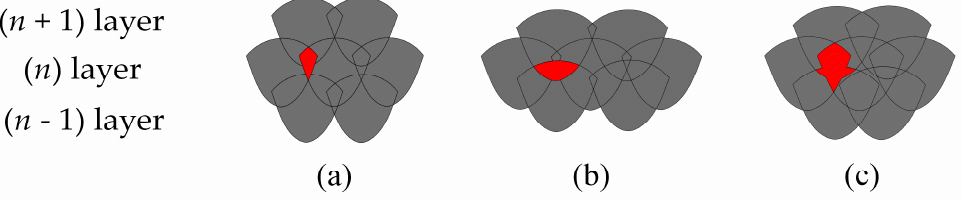
Figure 4. Three types of overlapping regimes under inter-layer stagger scanning strategy: ( a ) intra-layer; ( b ) inter-layer; and ( c ) mixed overlapping regime